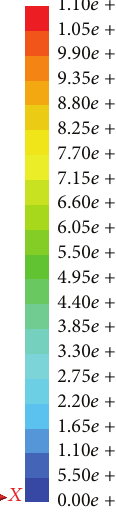
Figure 13: Contour of the number density of bin fraction 20 for nozzles 1, 3, and 5.